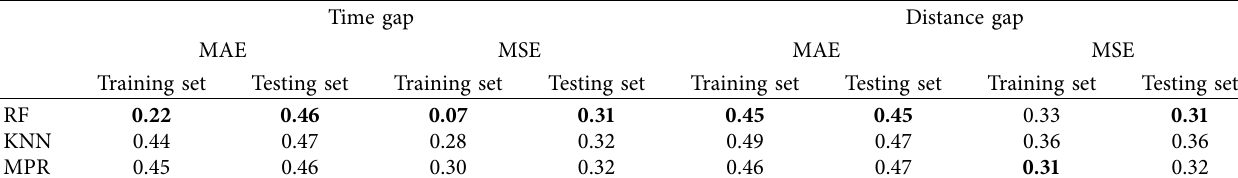
Table 3: Results of several models.